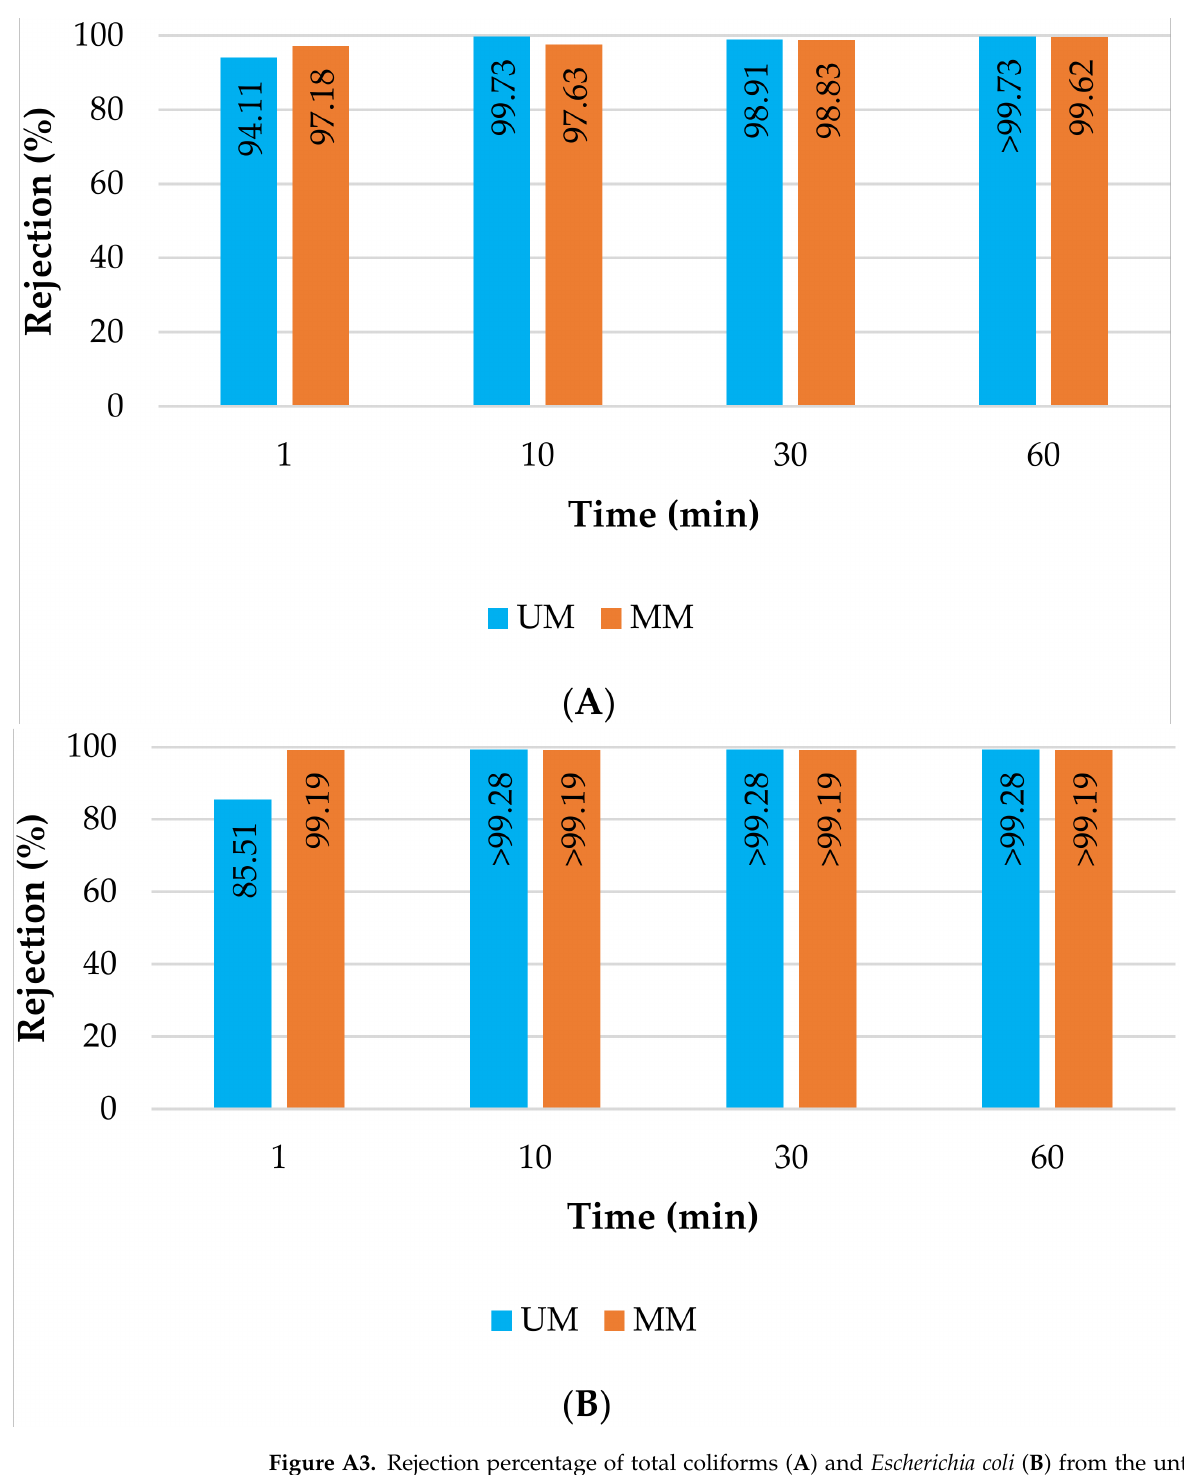
Figure A3. Rejection percentage of total coliforms ( A ) and Escherichia coli ( B ) from the untreated surface water samples with unmodified (UM) and modified membrane (MM) after 1, 10, 30, and 60 min of filtration. Values marked “>” indicate that the target microorganisms were not detected in the treated water